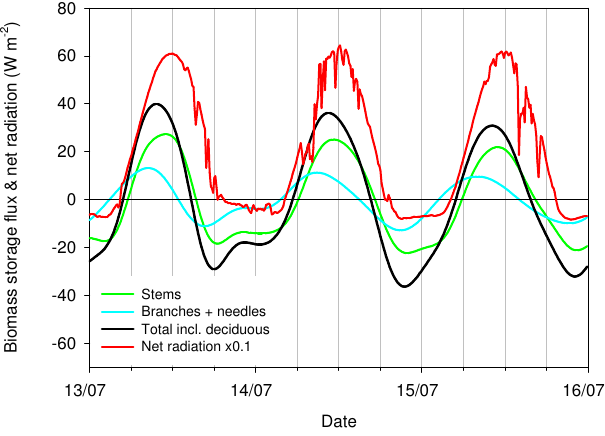
Fig. 4. The storage flux in the biomass of the entire stand divided into stem, branch plus needles and the total biomass storage flux during three summer days. Net radiation is also shown for compar- ison.